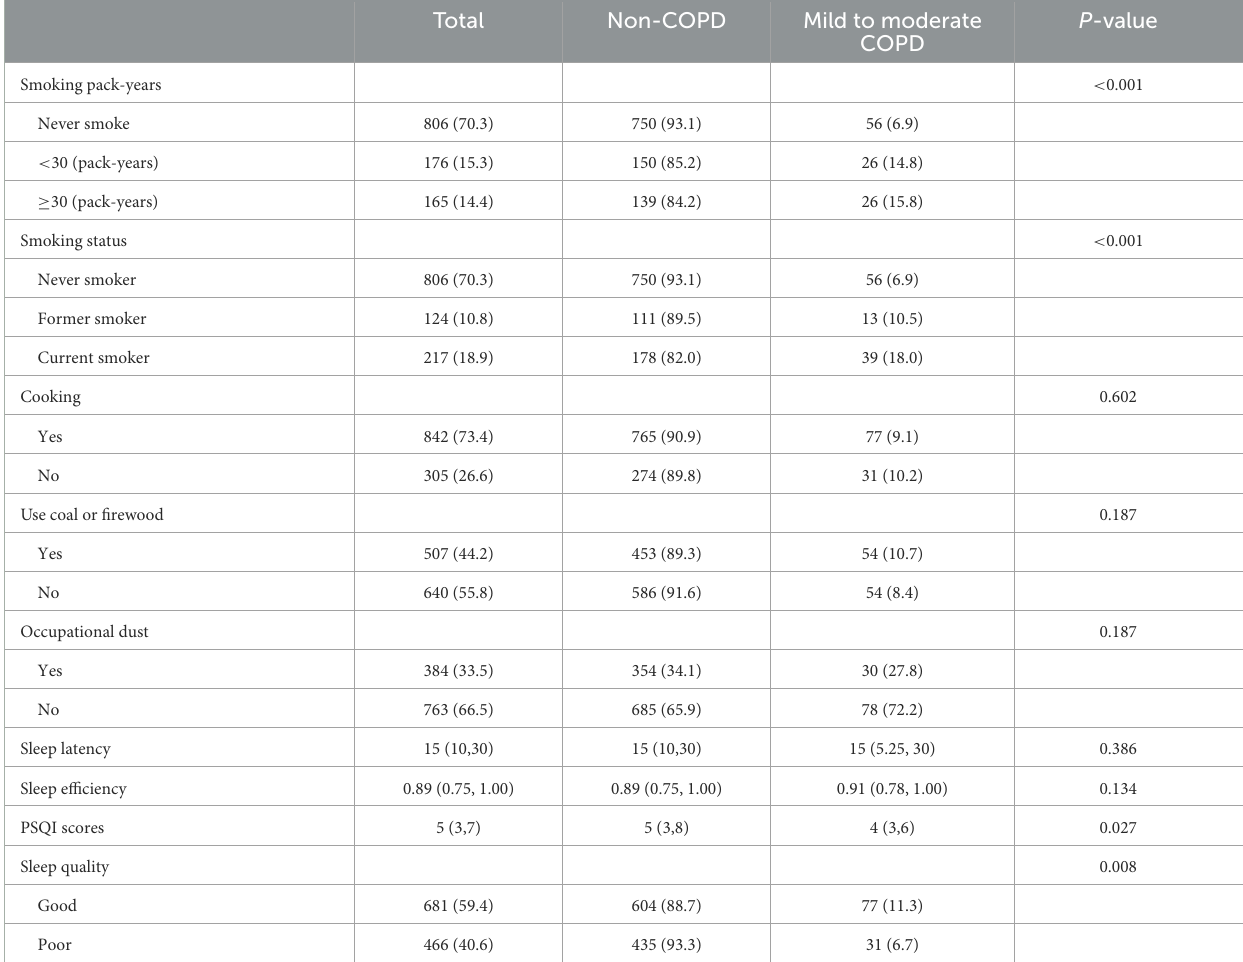
TABLE 3 Living behaviors of 1,147 of participants with/without COPD.